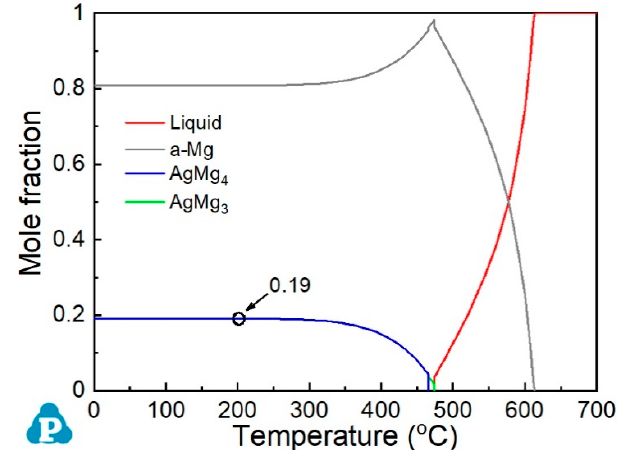
Figure 1. Calculated equilibrium mole fraction of phases as a function of temperature for a binary Mg–15Ag (wt.%) alloy using the PANDAT software.